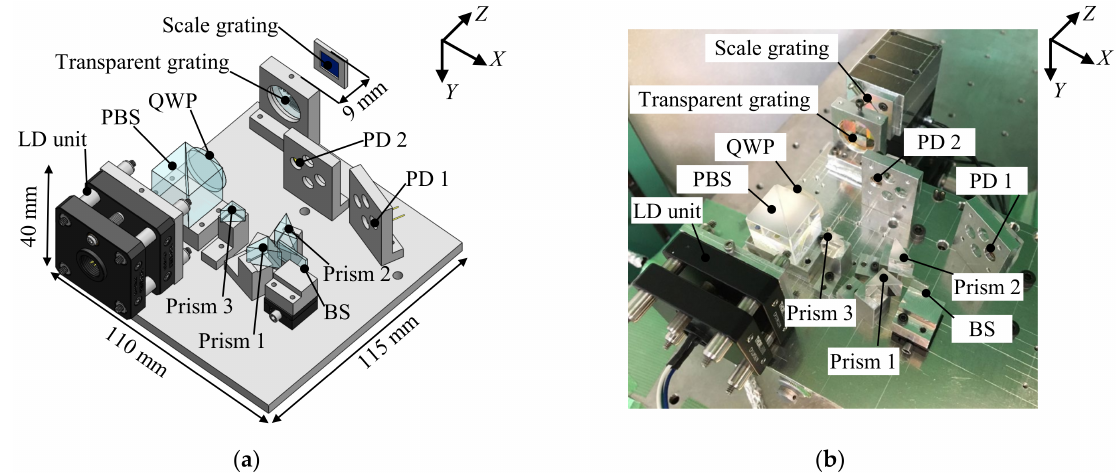
Figure 5. Prototype sensor head: ( a ) A three-dimensional model; ( b ) a